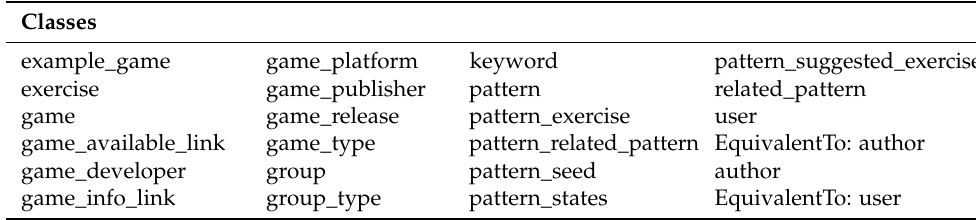
Table 1. Ontology classes for representing a pattern.